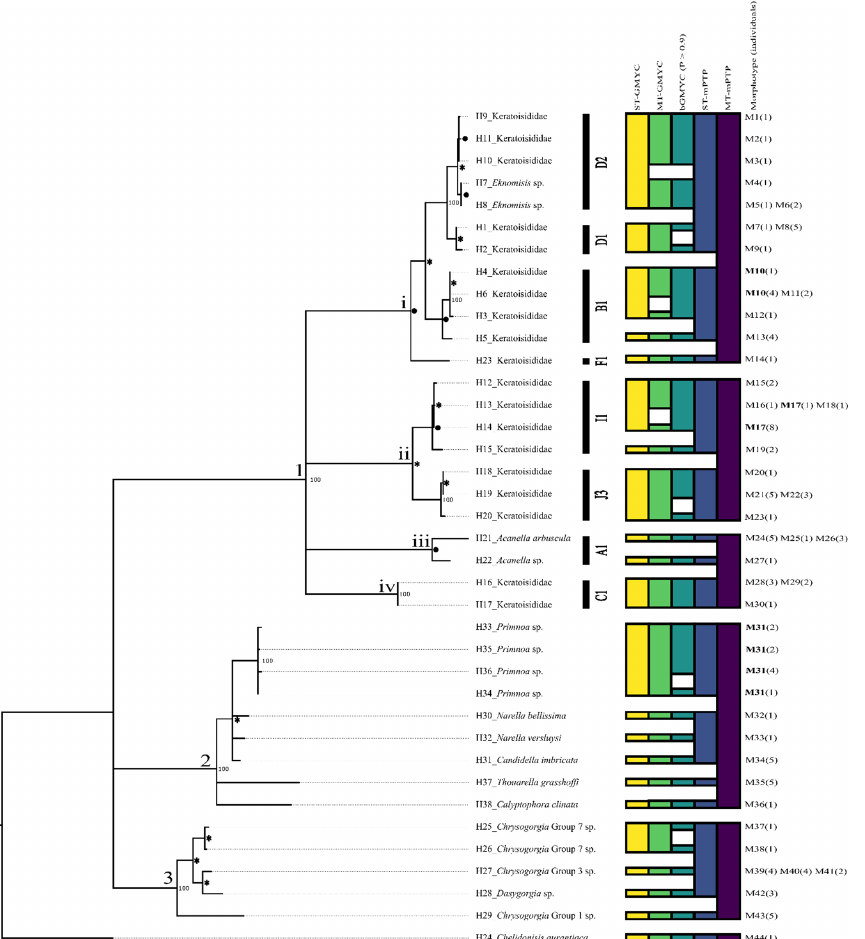
Figure 6. Maximum likelihood tree of all recovered haplotypes (H) and corresponding morphotypes (M) from the 3390 base pair alignment and the corresponding species delimitation results from GMYC and mPTP methods (ST = single threshold and MT = multiple threshold). Each box within each column refers to a unique species recovered by that method. 1. Family Keratoisididae. A1, B1, C1, D1, D2, F1, I1, and J3 refer to the keratoisidid subclades defined by Watling et al. [16] , 2. Family Primnoidae, and 3. Family Chrysogorgiidae. * represent bootstrap values 90–99. ● represents bootstrap values between 71–89. Nodes with support lower than 70 have been collapsed and bootstrap values not displayed.